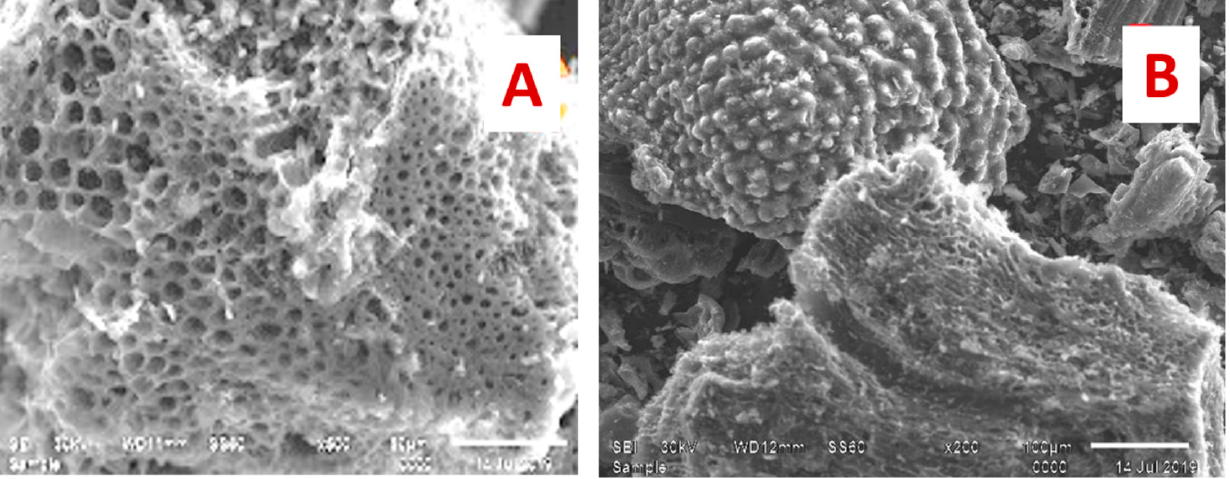
Figure 5. SEM of (AC(C-3) ( A ) before adsorption, ( B ) after adsorption Fe(III) and Mn(II).